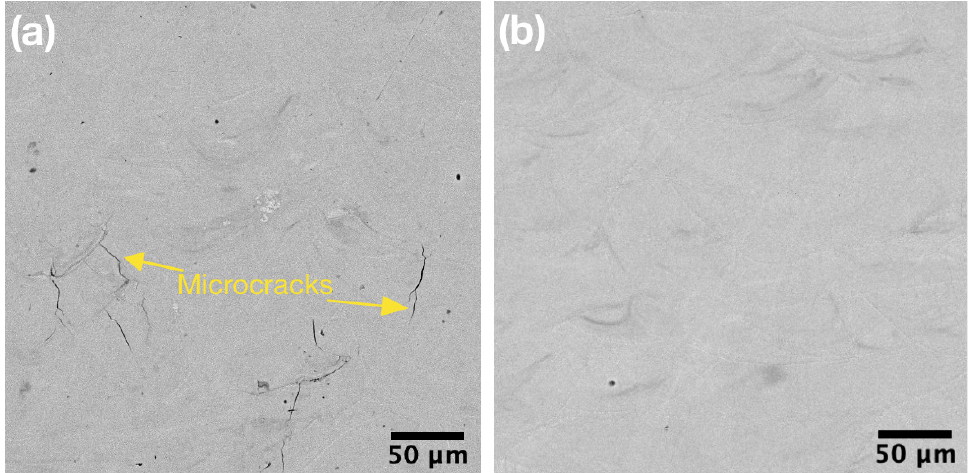
Figure 5. BSE-SEM images of the samples produced from ( a ) Ti 2 AlNb-noCYB and ( b ) Ti 2 AlNb-CYB powders at 700 °C preheating temperature showing the presence of microcracks in the case of the Ti 2 AlNb-noCYB powder.